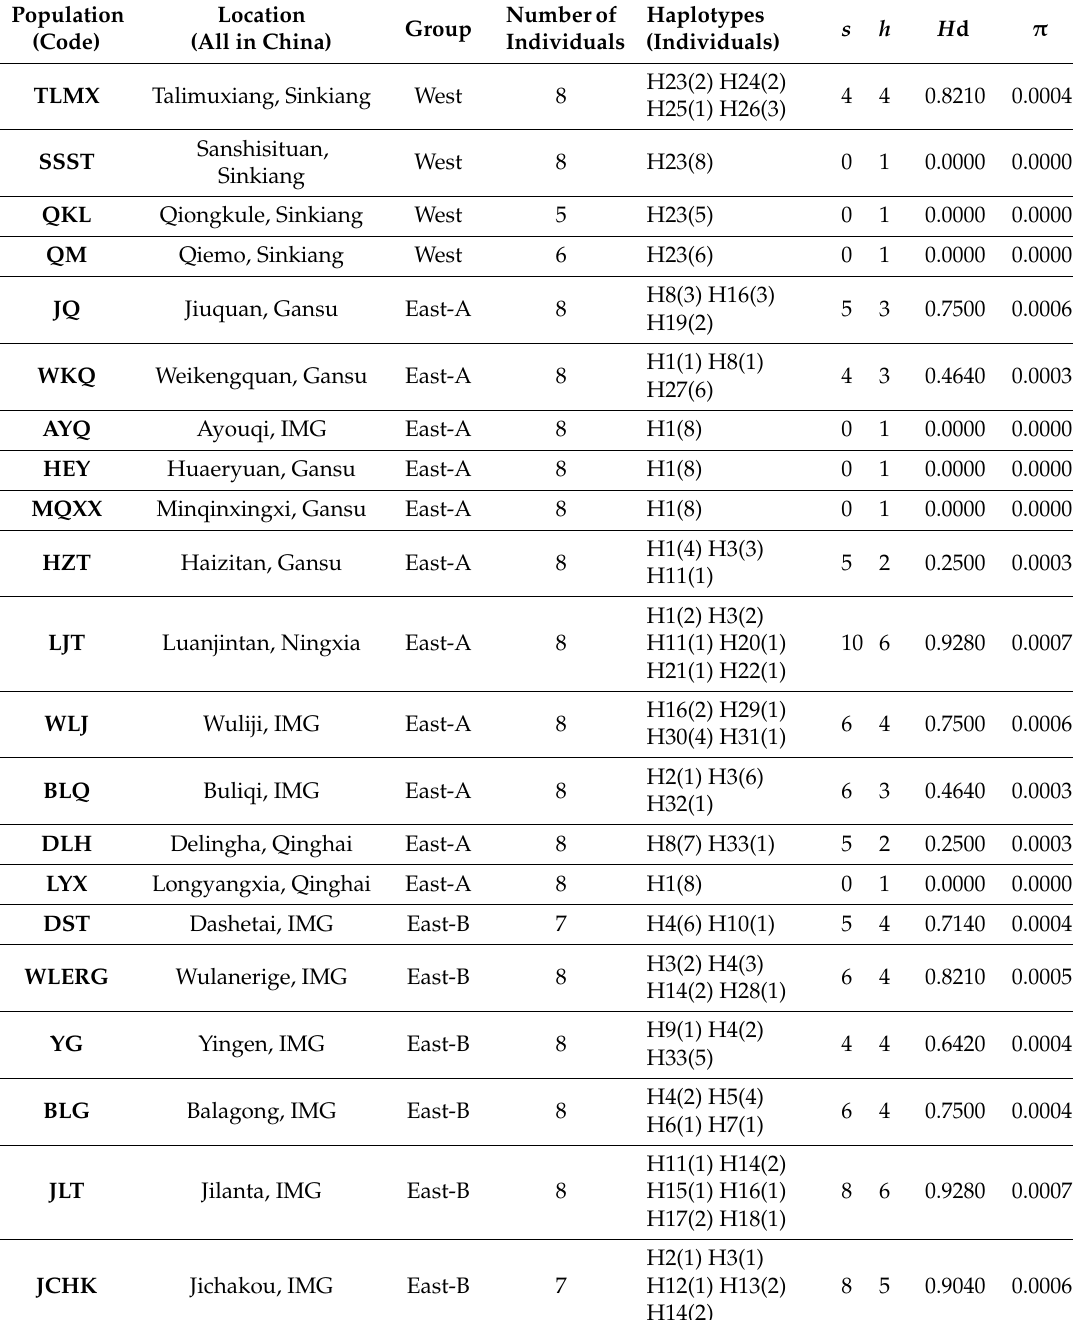
Table 1. Geographic and genetic information for the sampled populations of Nitraria tangutorum. s , number of segregating sites; h , number of haplotypes; H d, estimates of haplotype diversity; π , nucleotide diversity within